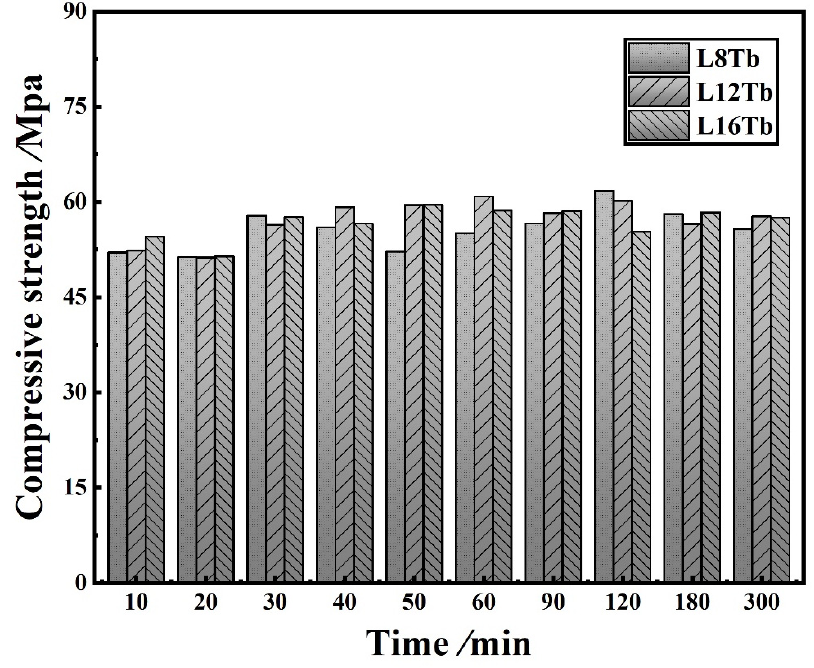
Figure 8. Compressive strength of layered samples.